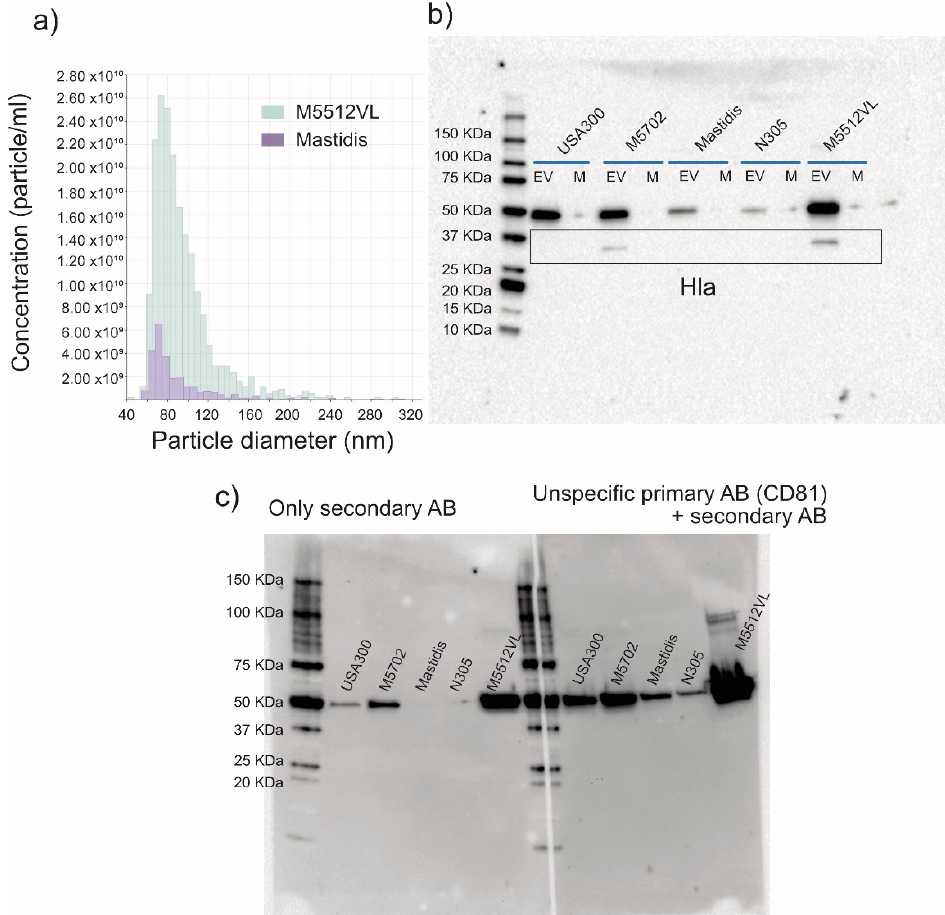
Figure 2. ( a ) Representative graphs of size distribution and particle concentration of S. aureus M5512VL EV (grey) and S. aureus Mastidis EV (purple), determined by tunable resistive pulse sensing technology (TRPS). ( b ) Western blot characterization for alpha-haematoxylin (Hla) using the same amount of total protein from EVs and culture media before EV isolation (M) of each S. aureus strain. ( c ) Negative control Western blots. The image shows an unspecific band at 50 KDa from the secondary AB. After the blocking step, the membrane was cut in two. The left part of the membrane was incubated with blocking buffer overnight and with the secondary antibody, while the right part was incubated with the unspecific primary antibody (CD81) that is not present in S. aureus and with the secondary antibody. Original Western blot figures are shown in Supplementary Figure S4.